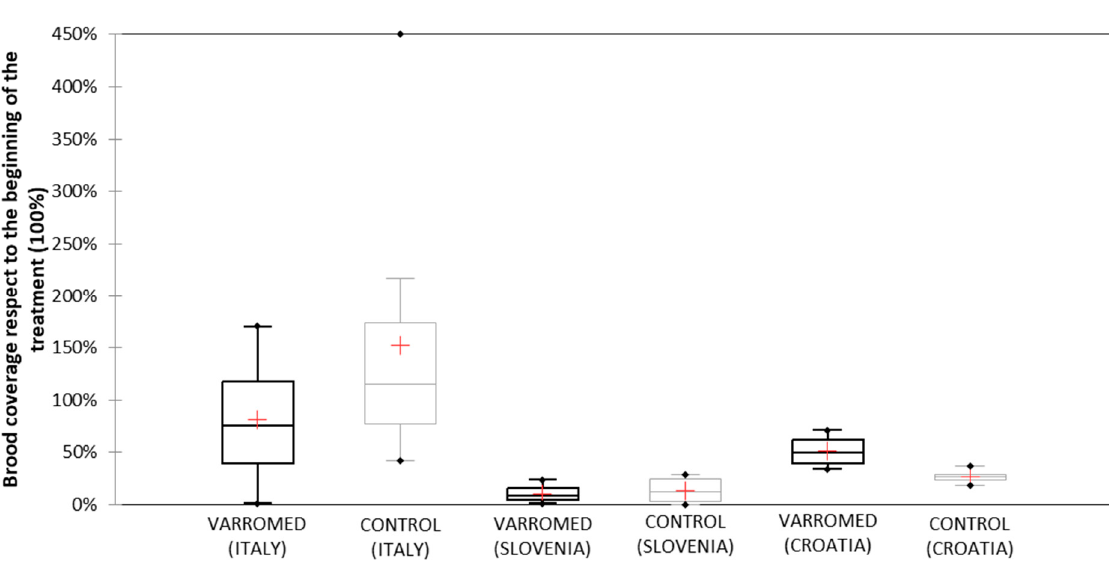
Figure 6. Box plot of brood area in all groups recorded during the summer/autumn trial compared to the beginning of the treatment (%). The horizontal line in boxes shows the median. The box shows the first and third quartile. Whiskers extend to 1.5 × interquartile range (IQR). Diamonds mark the outliers outside the 1.5 × IQR. Additionally, the pluses show mean values.